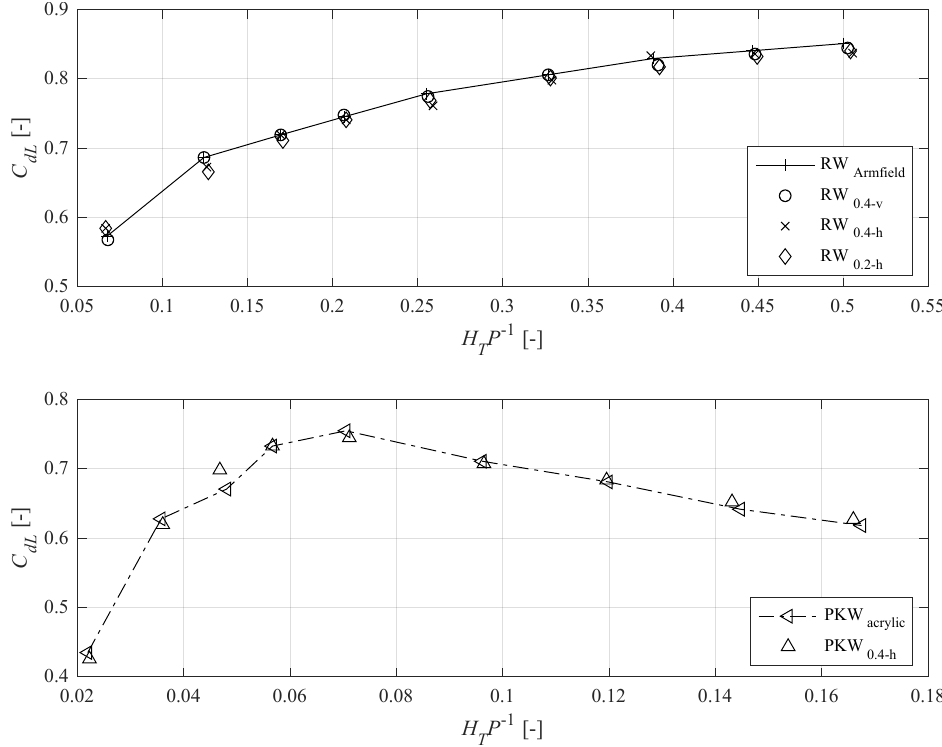
Figure 6. Discharge coefficients C dL , top : regular weirs, bottom : piano key weirs.